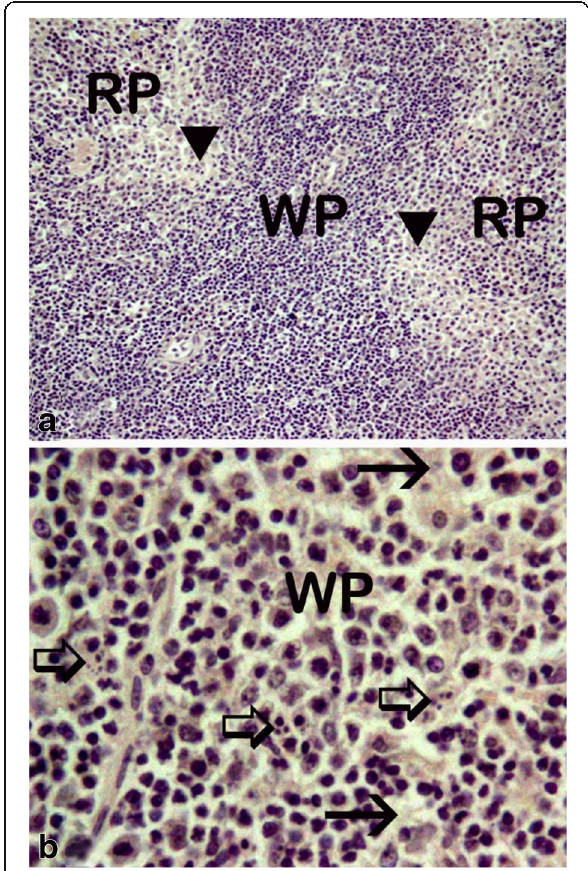
Fig. 8 Histological sections of the spleen from mice in G2 infected with T. congolense and treated with 2000 mg/kg of C. swynnertonii extracts, 8 hourly intervals but died on 2nd day of treatment. There is expansion of the lymphoid follicles and widening of marginal zone (arrow heads) in ( a ). Apoptosis characterized with pyknosis ( black arrows) and karyorrhexis (open arrows) of lymphocytes in ( b ). Magnifications, ( a ) 100 x: ( b ) 1000 x